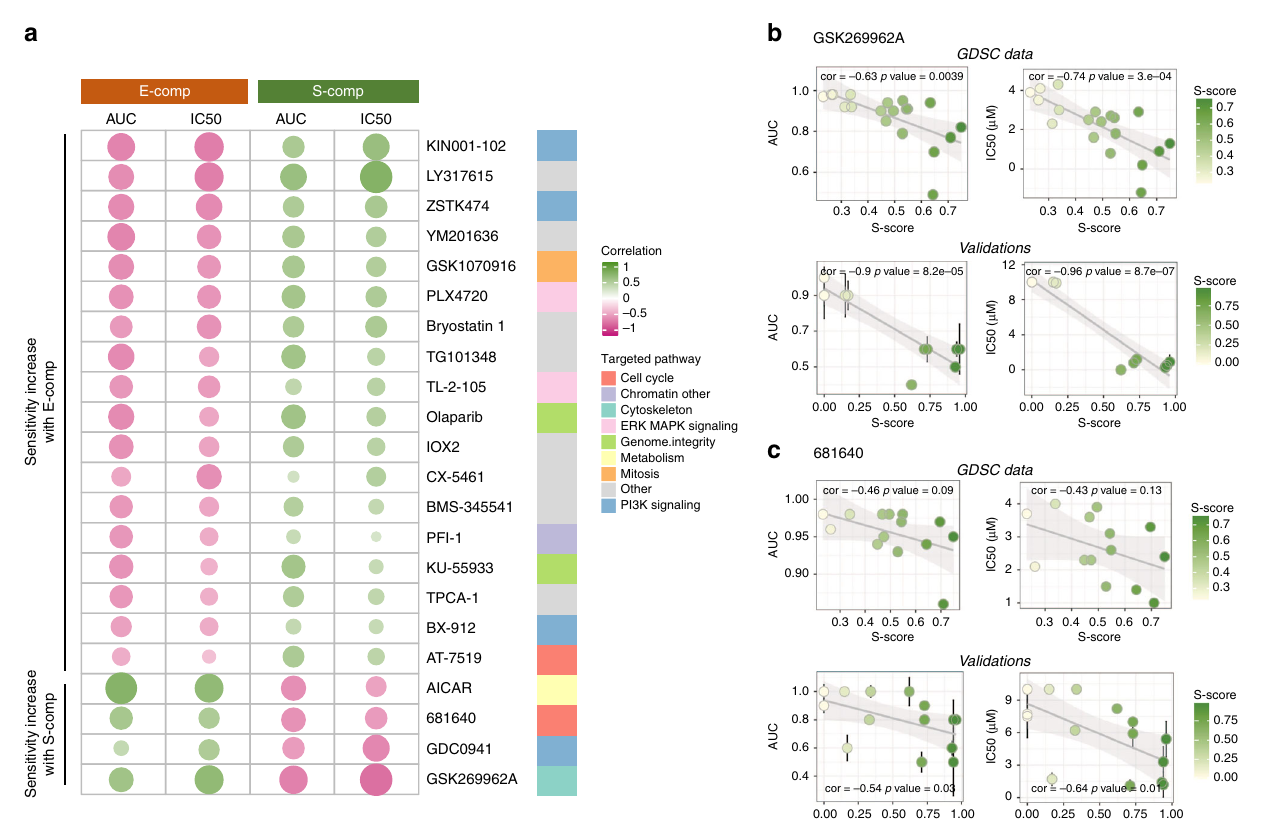
Fig. 4 Association with drug sensitivity. a Heatmap of the correlations between the AUC and IC50 and E -score and S -score for the drugs included in the GDSC database with at least one signi fi cant correlation with the components ( P value < 0.05). The circle size is proportional to the correlation value. The drugs are ordered on either side by their negative correlations with the E -score or S -score, which corresponded to a sensitivity increase along the component. The signaling pathways targeted by these inhibitors are mentioned on the right. b , c AUC and IC50 plots (error bars correspond to s.d.) obtained from the GDSC data or determined from our validation experiments vs. the S -score for GSK269962A ( b ) and 681640 ( c ). The color gradient represents the range of S -score. For each plot, the correlation coef fi cient and P value are shown (Pearson ’ s correlation